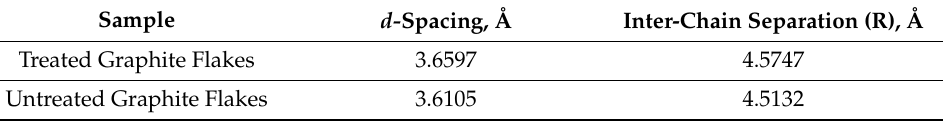
Figure 9. XRD Spectra of Treated and Untreated Graphite Flakes. Table 4. d-Spacing and Crystallite Size for All 2 θ = 24.6° Peaks in Treated and Untreated Graphite Flakes.